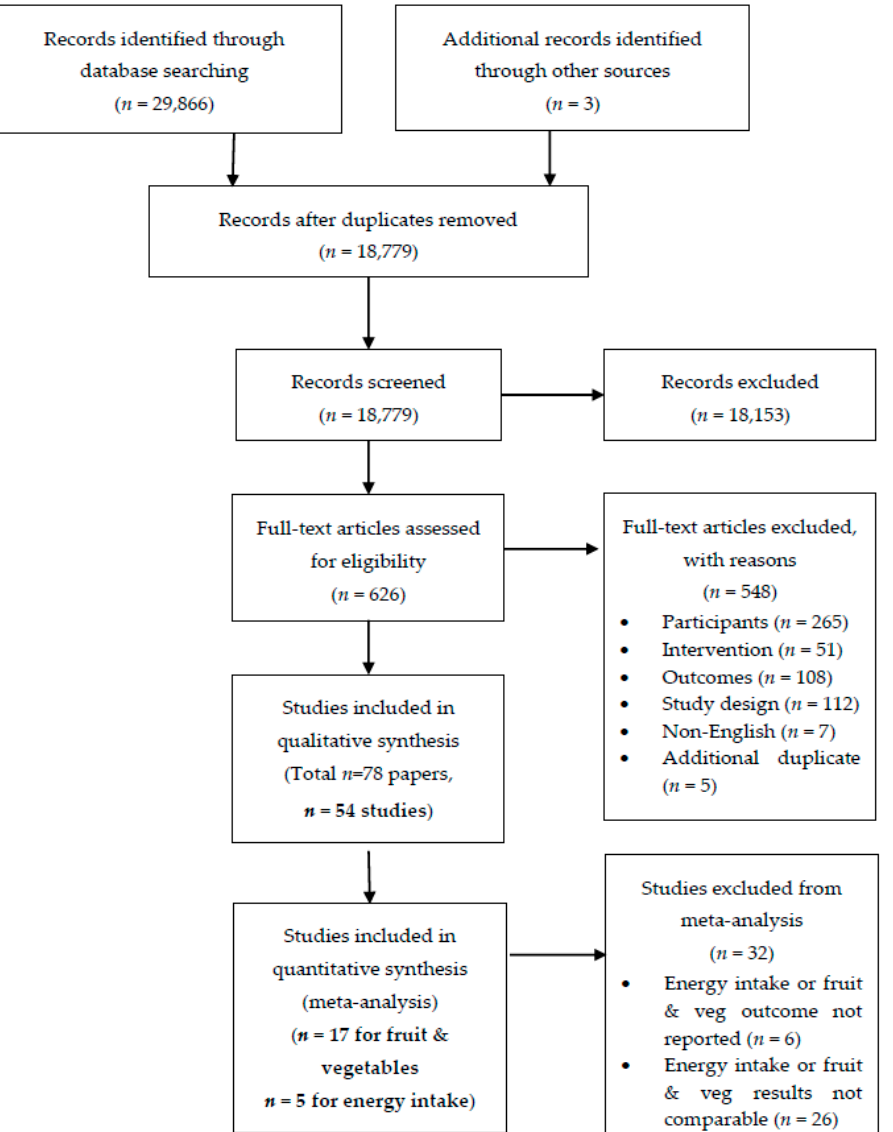
Figure 1. PRISMA flow diagram of included studies.